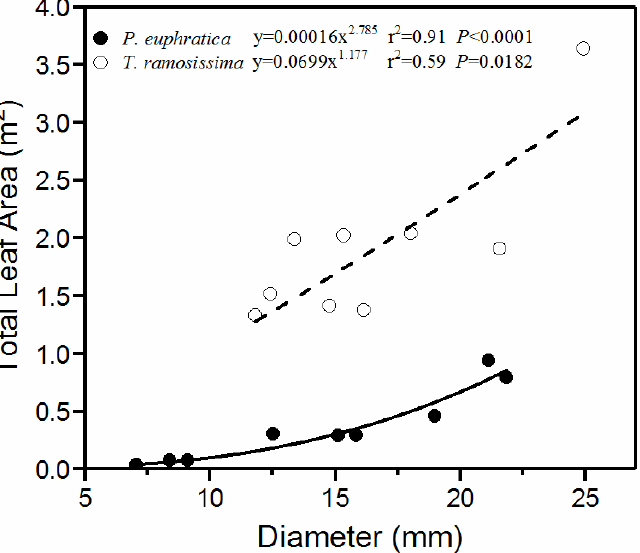
Table 1. Rooting depths (cm) of P. euphratica and T. ramosissima grown at 20 cm, 60 cm, and 100 cm groundwater depths (DGW). Values are means ± SE ( n = 3).